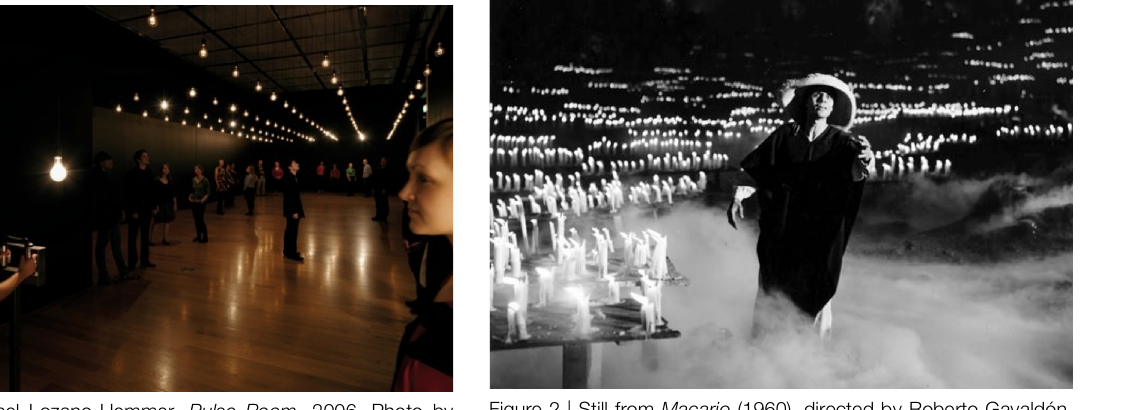
Figure 1 | Rafael Lozano-Hemmer, Pulse Room , 2006. Photo by Peter Mallet.